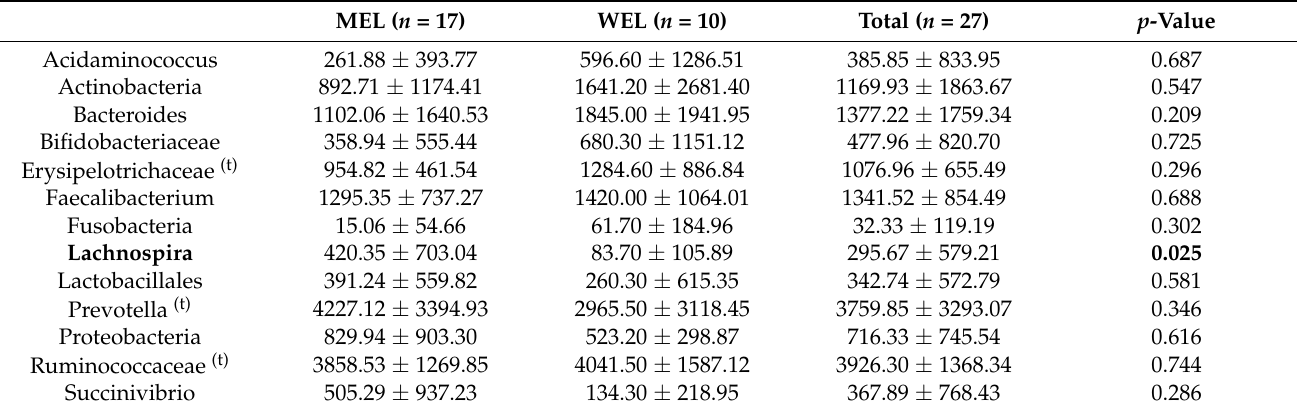
Table A4. Number of readings of the main bacterial taxa in the gut microbiota by dietary